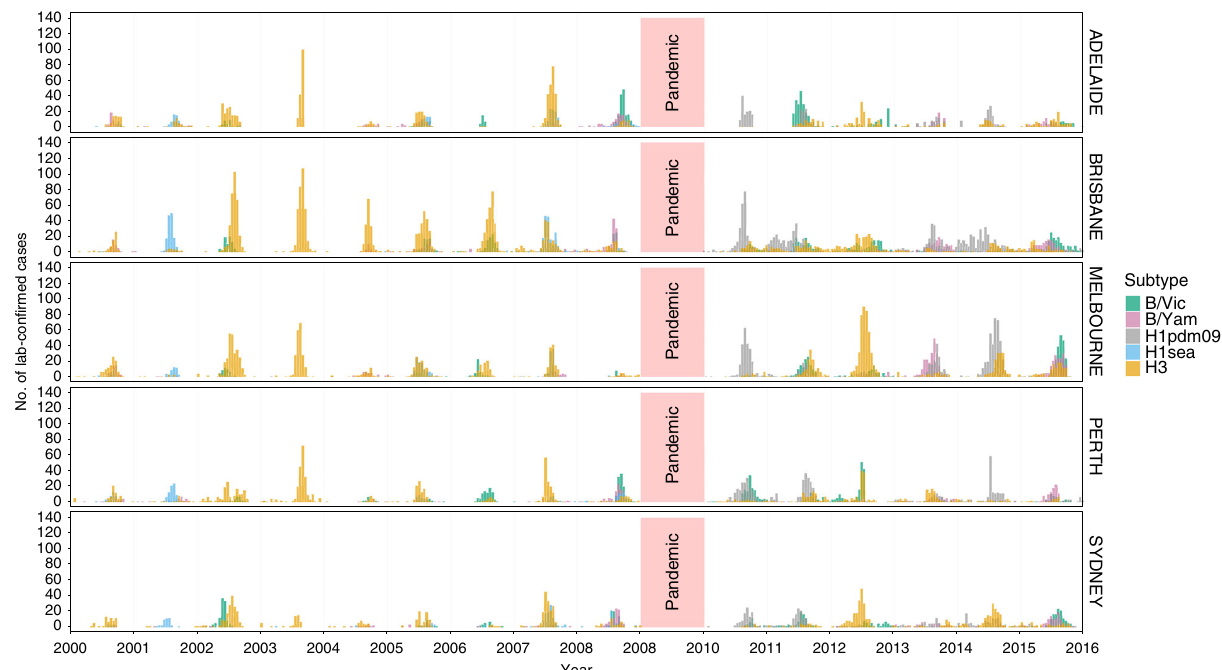
Fig. 1 Number of laboratory-con fi rmed seasonal in fl uenza virus infections from 2000 to 2015 for the fi ve largest cities in Australia. Cases are aggregated by 2-week periods, strati fi ed by city and coloured by